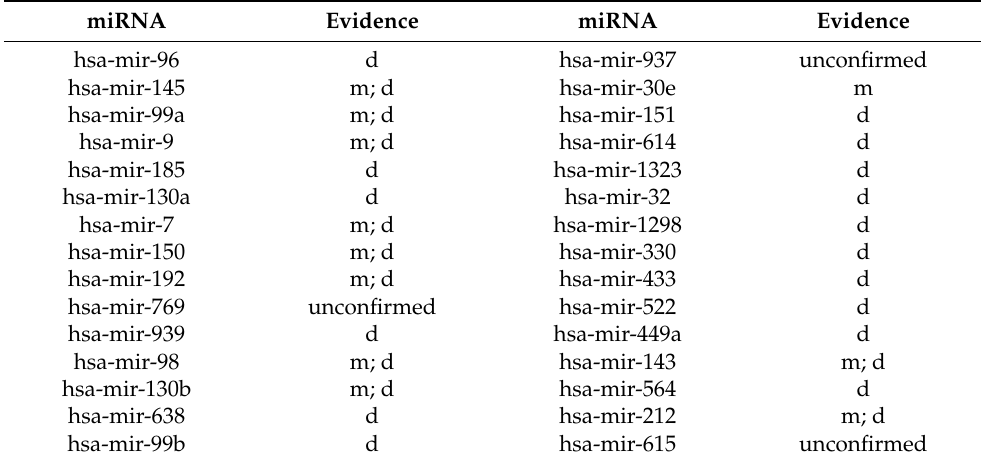
Table 3. The top 30 potential miRNAs associated with lung neoplasms.